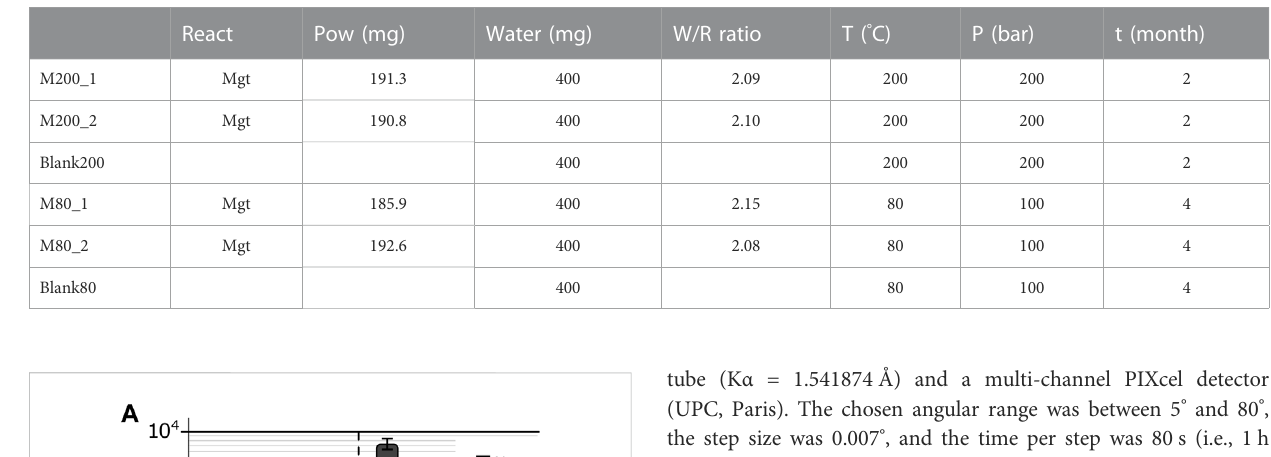
TABLE 1 Summary of experimental settings for each capsule. Mgt refers to magnetite.